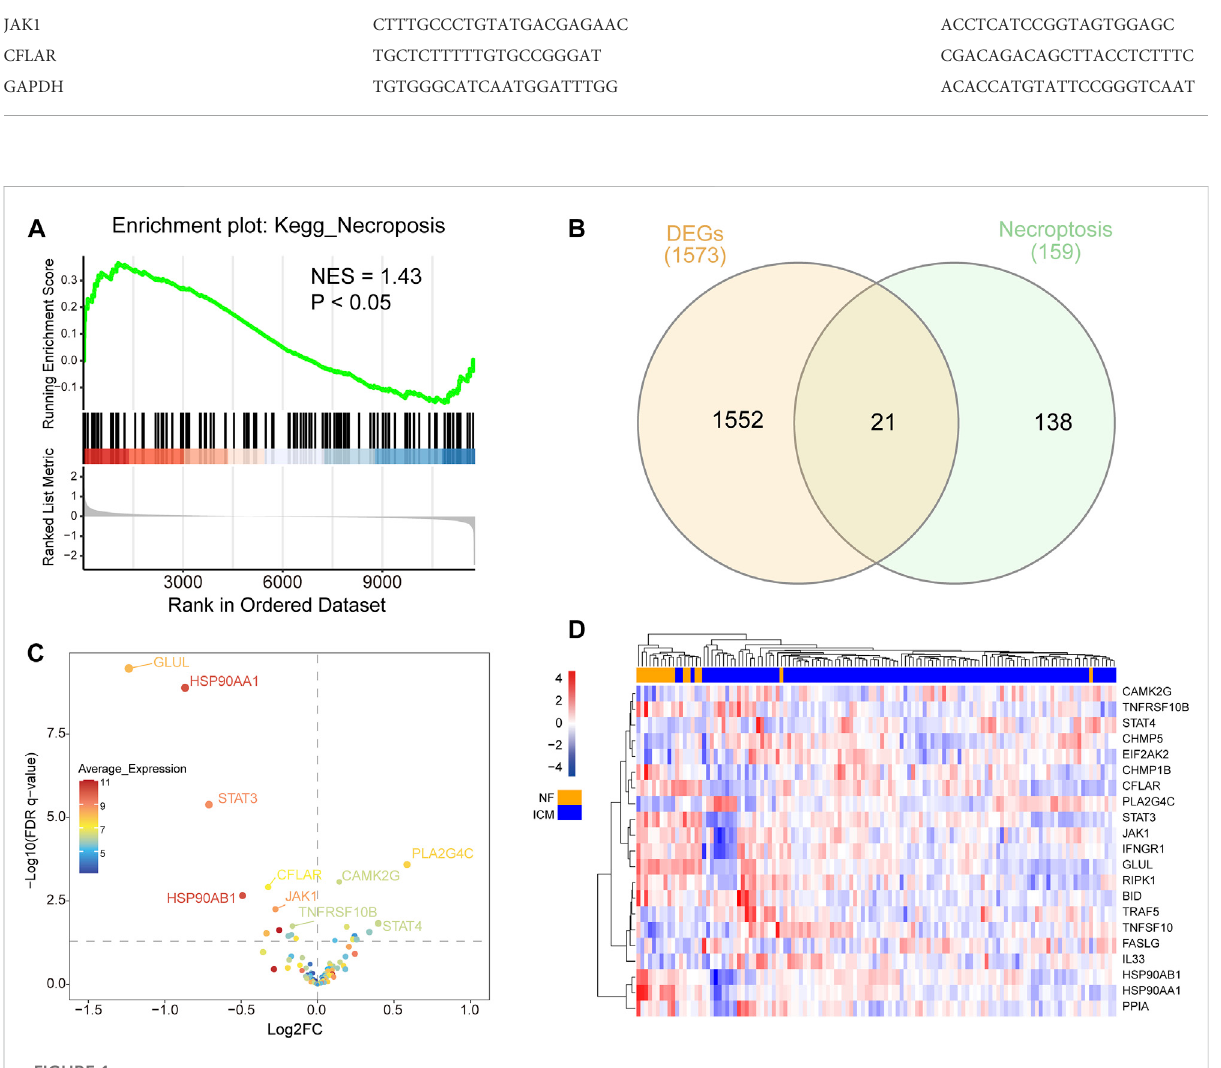
FIGURE 1 (A) Differential expression of necroptosis-related genes in heart samples of ICM and controls. (B) Venn diagram showing the overlap of genes betweenDEGsinGSE5406andnecroptosis-relatedgenesinKyotoEncyclopediaofGenesandGenomespathwaydatabases. (C) Thevolcanoplotof NRDEGs. (D) Clustered heatmap of